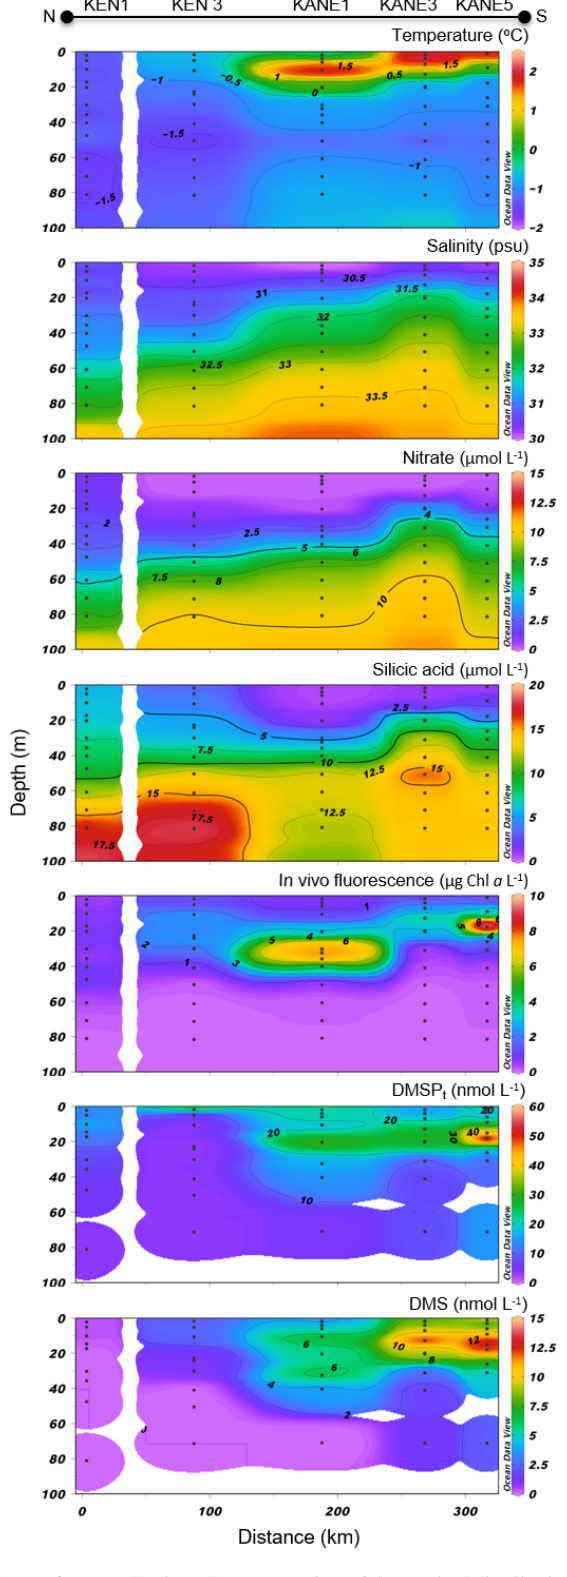
Figure 6. Nares Strait (NS) cross section of the vertical distributions of temperature, salinity, nitrate, silicic acid, in vivo fluorescence, DMSP t , and